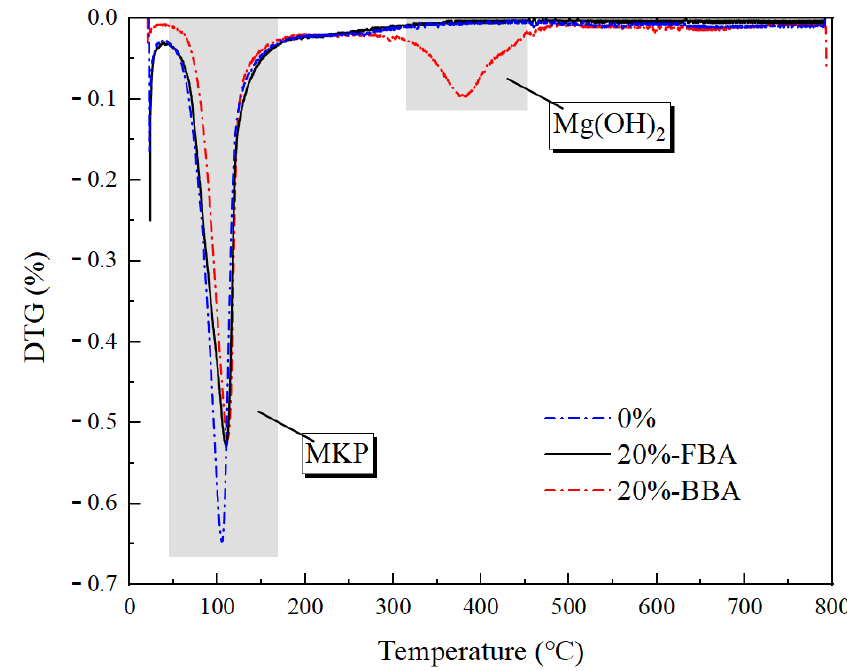
Figure 14. The TGA curves of MPC paste with or without BA at 28 days.